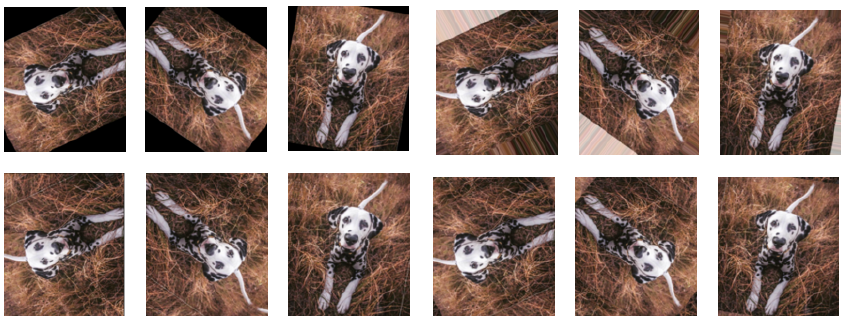
Figure 5. Data augmentation by different types of rotation techniques. The left three figures in the first row show the “constant” technique, i.e., the traditional rotation (TR), resulting in black areas around the boundary. The RNR technique is used in the right three figures of the first row. The first three figures of the second row give the results of filling up the black areas by using RRR, and the right three figures use RWR. For each technique, three random angles were selected for